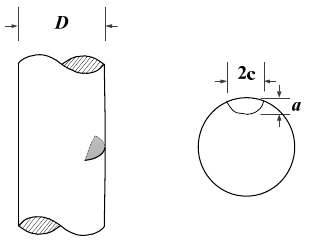
Figure 9. Schematic representation of surface crack in the specimen.